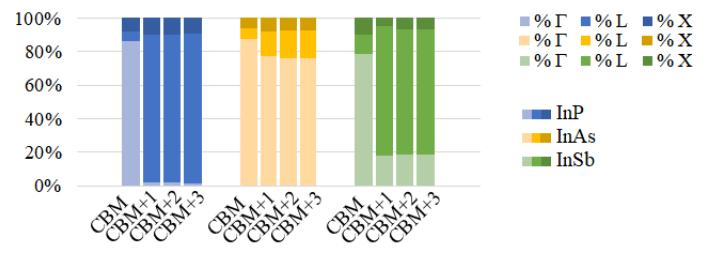
Figure 9. High symmetry points contribution to the CB states of InP, InAs and InSb QDs with cation-rich